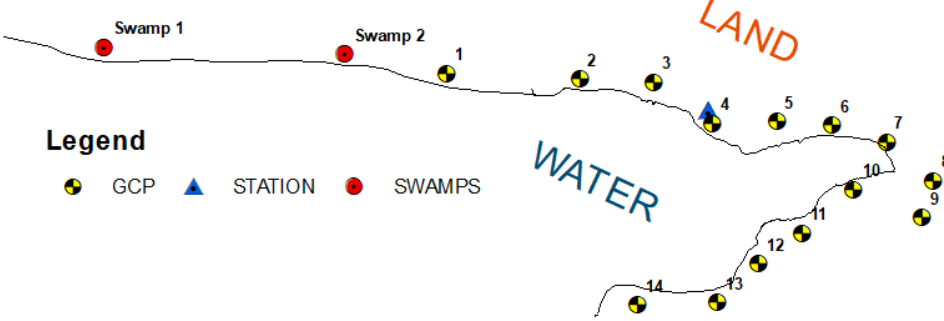
Figure 4. Total station location (blue triangle), GCPs (black and yellow dots) distribution and the two locations of SWAMP on Point 1 and Point 2 (red